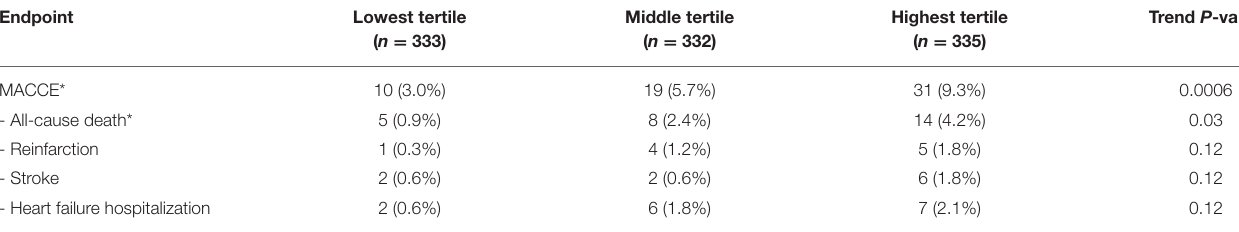
TABLE 3 | One-year clinical outcomes in cohort 3 STEMI patients according to peak S100A12 tertiles.